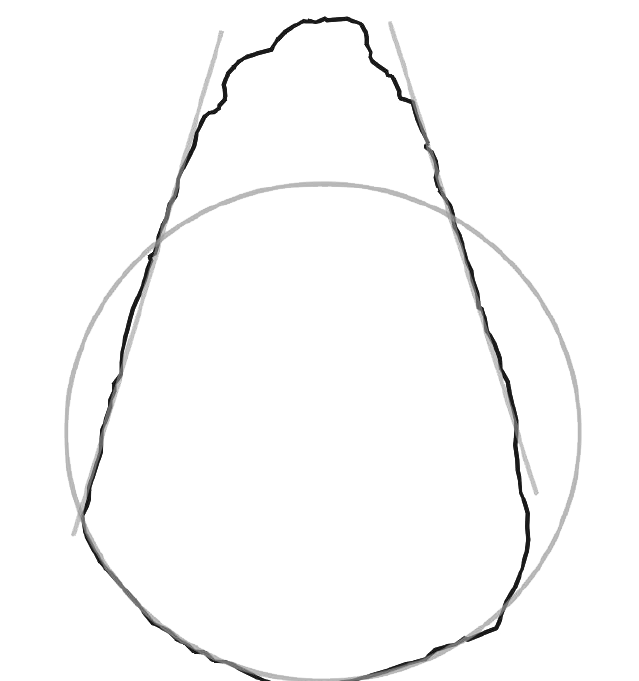
Figure 19. Outline of Specimen 40548 Lynford Quarry (from author’s photograph).